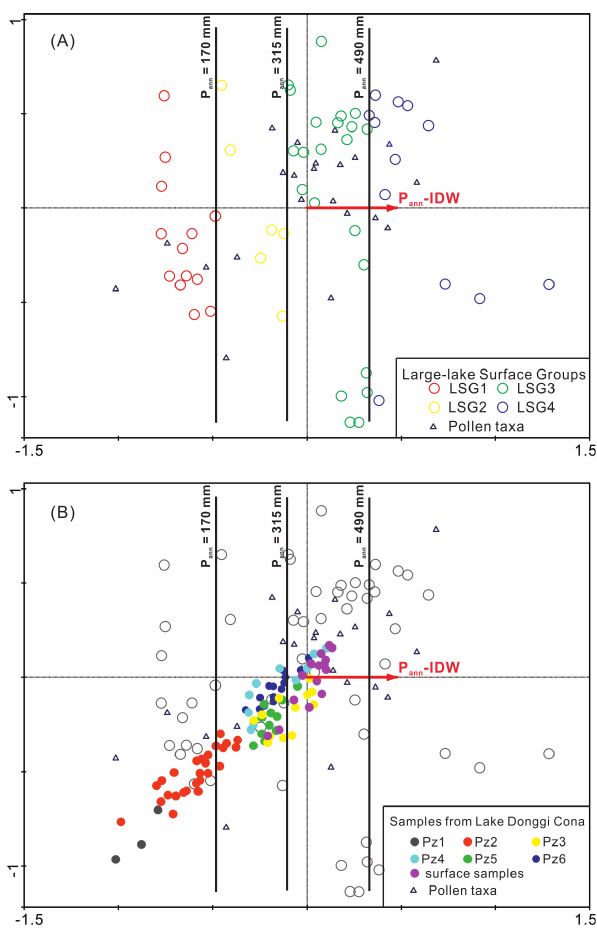
Fig. 5. (A) RDA tri-plot of surface pollen assemblages from 53 large lakes, constrained by inverse-distance-weighted mean annual precipitation ( P ann ) ; samples have been classified using different colours indicating different groups identified by MRT. (B) Fossil and modern pollen samples from Lake Donggi Cona are supple- mentary objects on the RDA plot of (A) : the bold black lines and associated precipitation results indicate the thresholds derived from the MRT